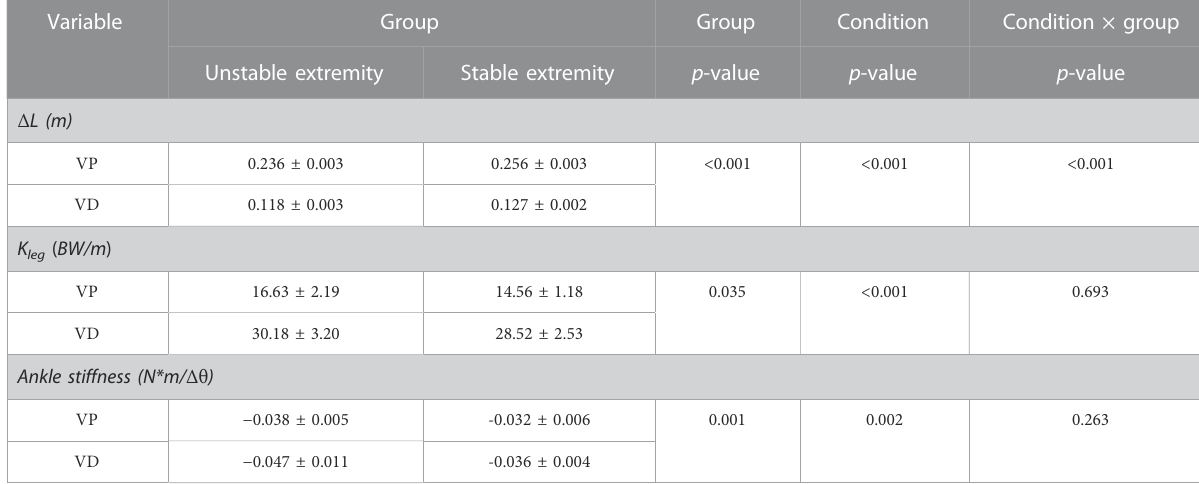
TABLE 4 Stiffness of FAI during landing with and without visual